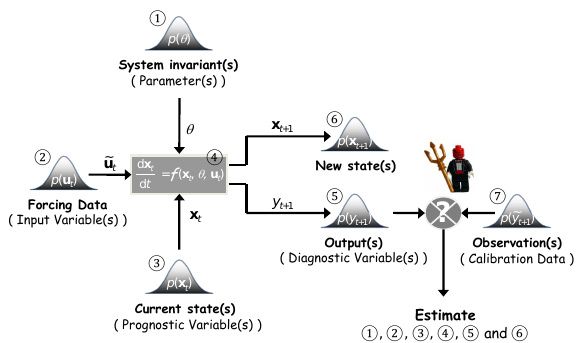
Fig. 1. Explicit recognition of the role of ( 1 ) parameter, ( 2 ) forc- ing data, ( 3 ) initial state, ( 4 ) model structural, ( 5 ) output, ( 6 ) state, and ( 7 ) calibration data uncertainty. The pitchfork symbol illumi- nates the difficulty with formulating the likelihood function (and prior distribution/parameterization of individual error sources) used to summarize the error residuals. Explicit treatment of individual error sources is required to increase the prospects of explaining the reasons for model inadequacy and learning from the experimental